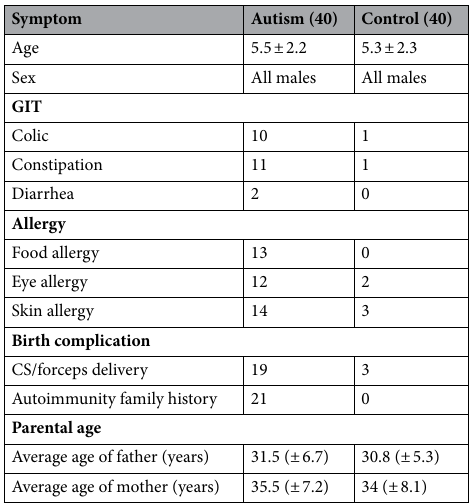
Table 1. Demographic available data of ASD patients and controls.